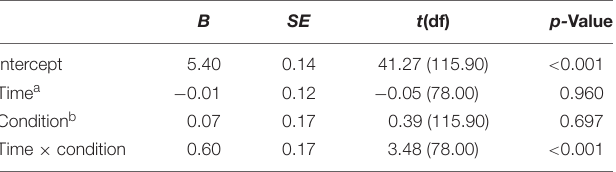
TABLE 2 | Coefficients of the best model selected (i.e., Model